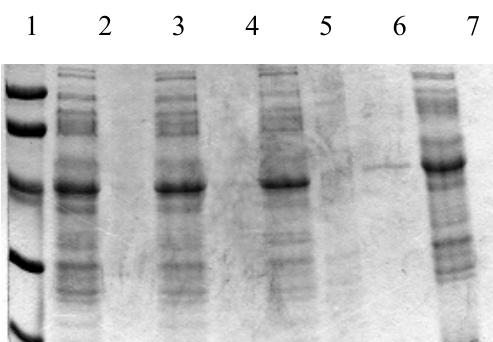
Figure 2. Cell lysis analyzed by SDS-PAGE on cell pellets and supernatants after incubation with different DCEO concentrations. Lane 1, molecular weight; lanes 2, 4, 6, and 8, cell pellets after treatment with DMSO (negative standard), DCEO at 2 × MIC, DCEO at 4 × MIC, and SDS 0.02% ( w / v ) respectively. Lanes 3, 5, 7, and 9, supernatants after treatment with DMSO (negative standard), DCEO at 2 × MIC, DCEO at 4 × MIC, and SDS 0.02% ( w / v ) respectively.